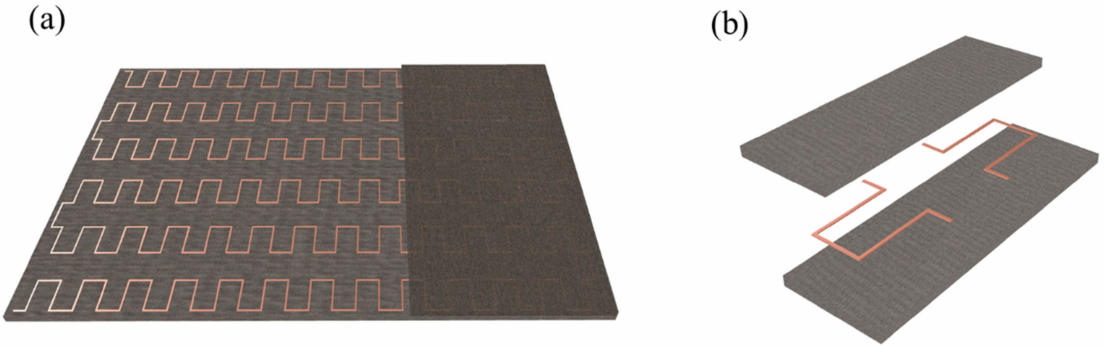
Figure 1. ( a ) Schematic diagram of serpentine heat source embedded in orthotropic membranes; ( b ) a single period of the periodic